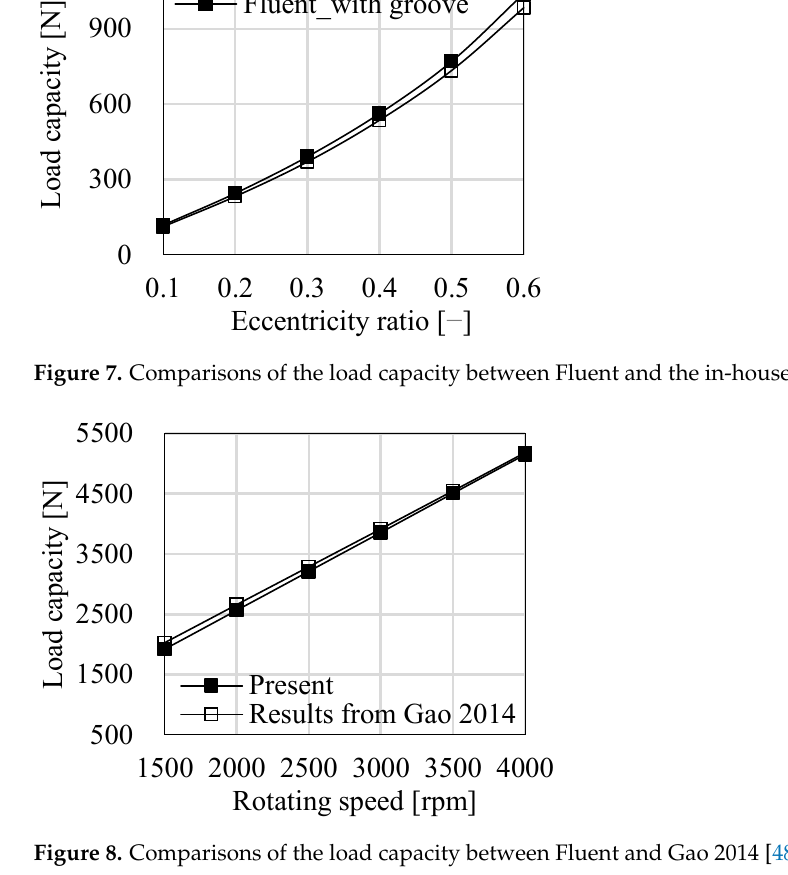
Figure 8. Comparisons of the load capacity between Fluent and Gao 2014 [48].